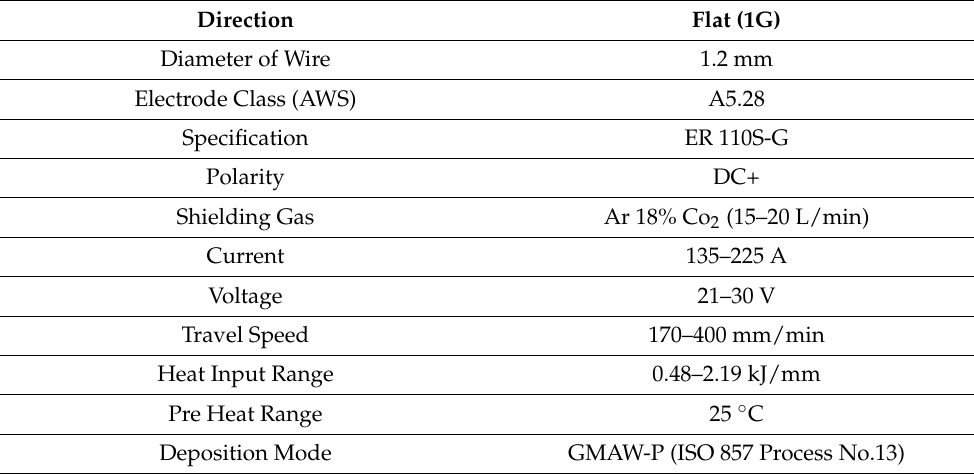
Table 2. Welding (GMAW-P) parameter and